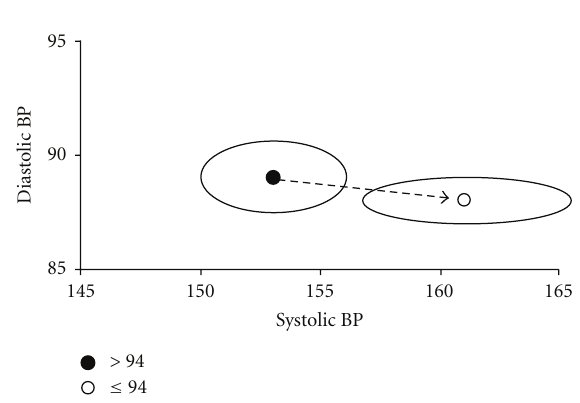
Figure 2: Vector analysis of the pair of variables “systolic blood pressure; diastolic blood pressure.” The points and the 95% confidence ellipses represent the mean values of systolic and diastolic pressure among subjects with cognitive reserve index ≥ 94 ( • ) and < 94 ( ◦ ), the cut-o ff of 94 representing the median of this continuous variable for this cohort. The vector of impairment (arrow) is directed towards significantly higher values of systolic (+6mmHg) and lower values of diastolic ( − 1